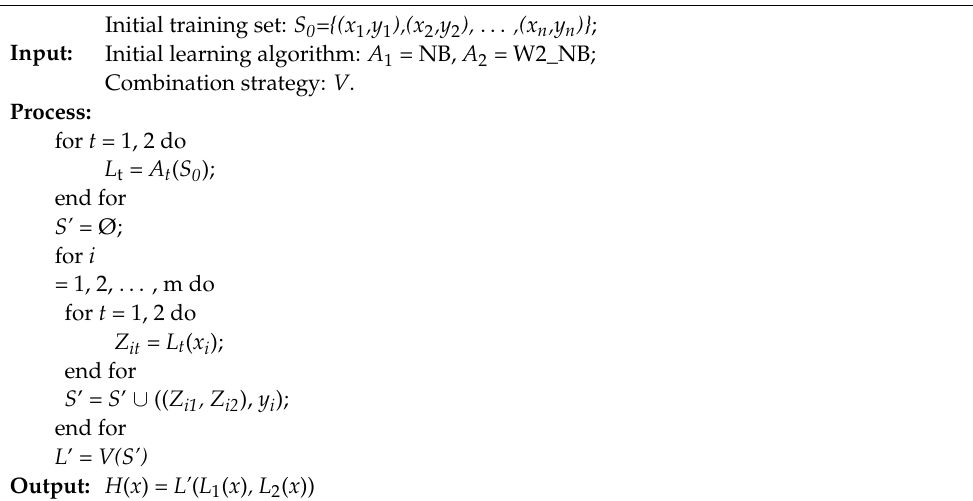
Algorithm 1: The flow of the multi-classifier fusion optimization